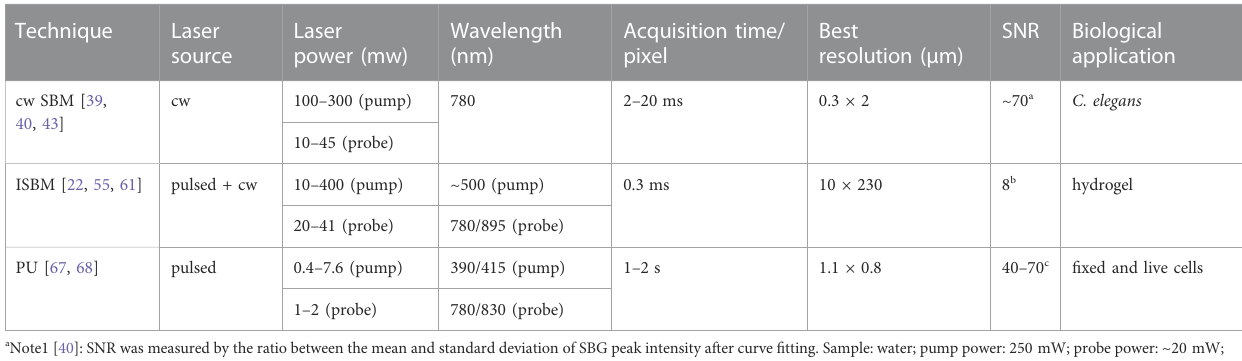
TABLE 1 Comparison of the representative stimulated Brillouin based